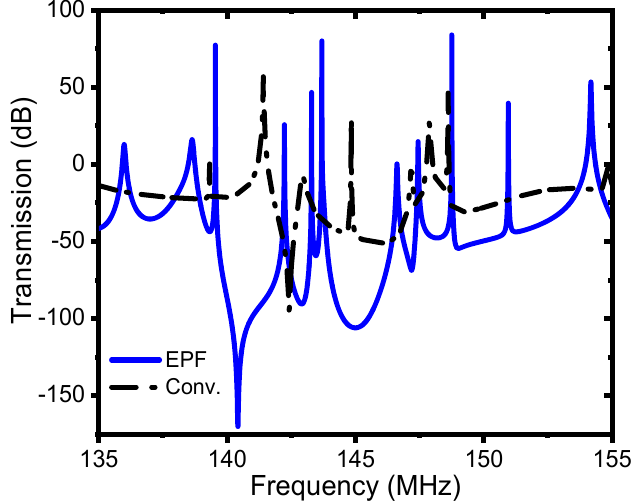
Figure 2. Transmission (dB) spectrum of the conventional and EPF resonators in the frequency range of 135 MHz to 155 MHz.